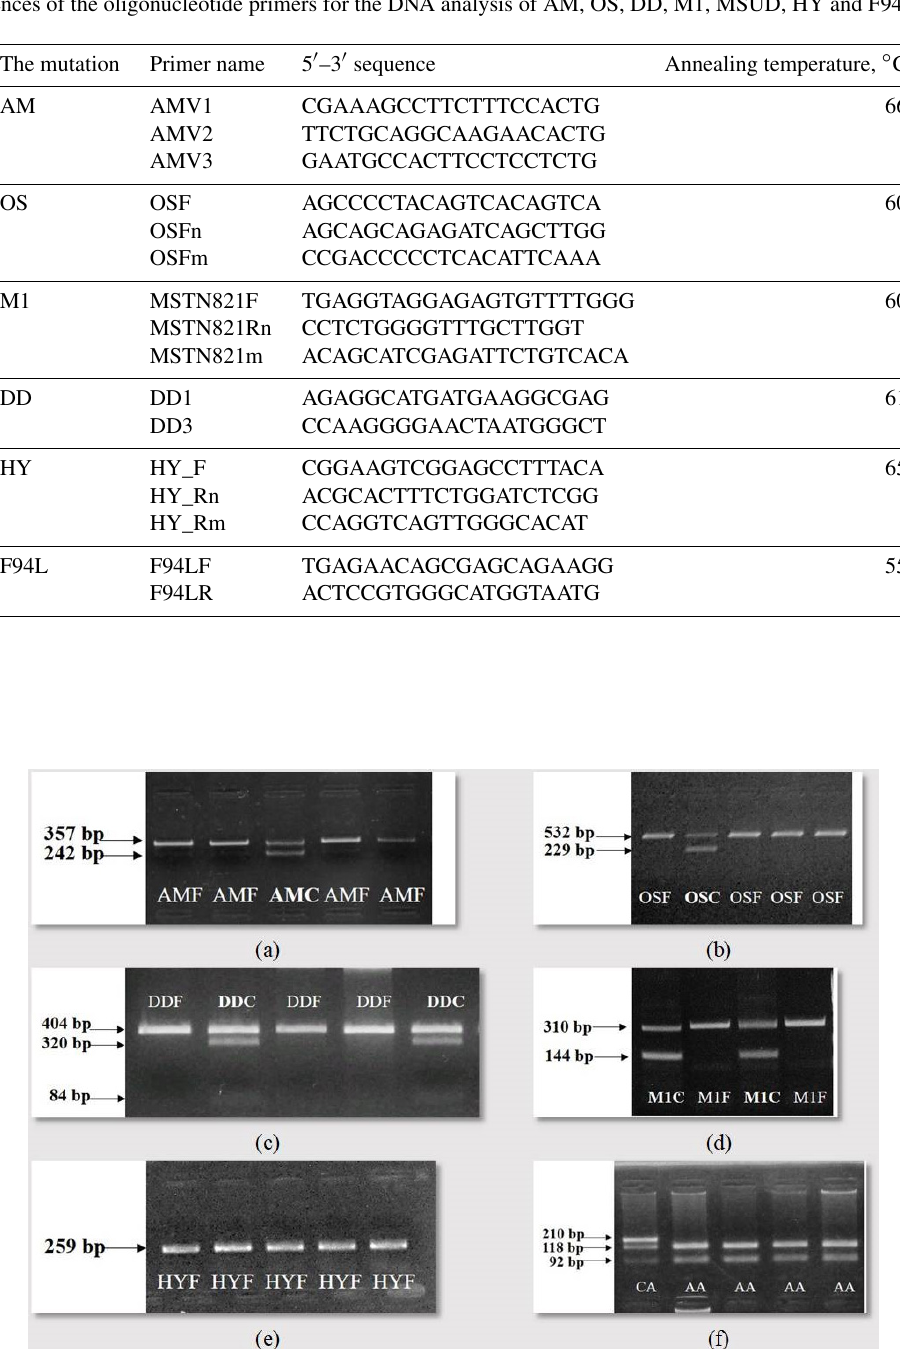
Figure 1. Gel electrophoresis of the amplification products: (a) arthrogryposis multiplex (AMF – arthrogryposis-free animal; AMC – arthro- gryposis carrier); (b) osteopetrosis (OSF – osteopetrosis-free animal, OSC – osteopetrosis carrier); (c) developmental duplication (DDF – developmental duplication-free animal; DDC – developmental duplication carrier); (d) double muscling (M1F – double-muscling-free ani- mal; M1C – double muscling carrier); (e) hypotrichosis (HYF – hypotrichosis-free animal); (f) genotyping for F94L MSTN polymorphism – presented genotypes of CA and AA